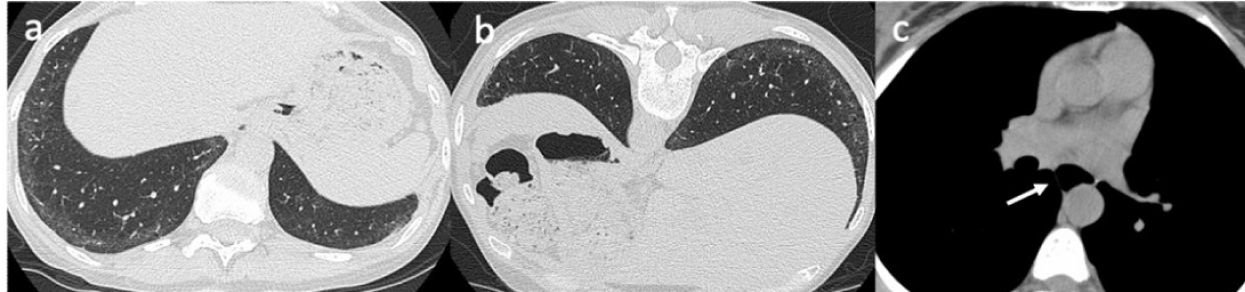
Figure 1. A 43-year-old female with a diagnosis of systemic sclerosis. Axial high-resolution CT scan obtained in the supine position shows subtle ground-glass opacities in the subpleural regions of the lung bases, suspicious for NSIP (non-specific interstitial pneumonia) ( a ). When these findings are not prominent, an additional scan can be acquired in the prone position to differentiate ground-glass opacities due to gravitational phenomena from interstitial lung disease. In this patient the ground-glass opacities persist in the prone position, confirming the interstitial lung involvement ( b ). Additional systemic sclerosis-related findings should be searched for, such as a dilated esophagus on images reconstructed using an appropriate mediastinal window setting ( c